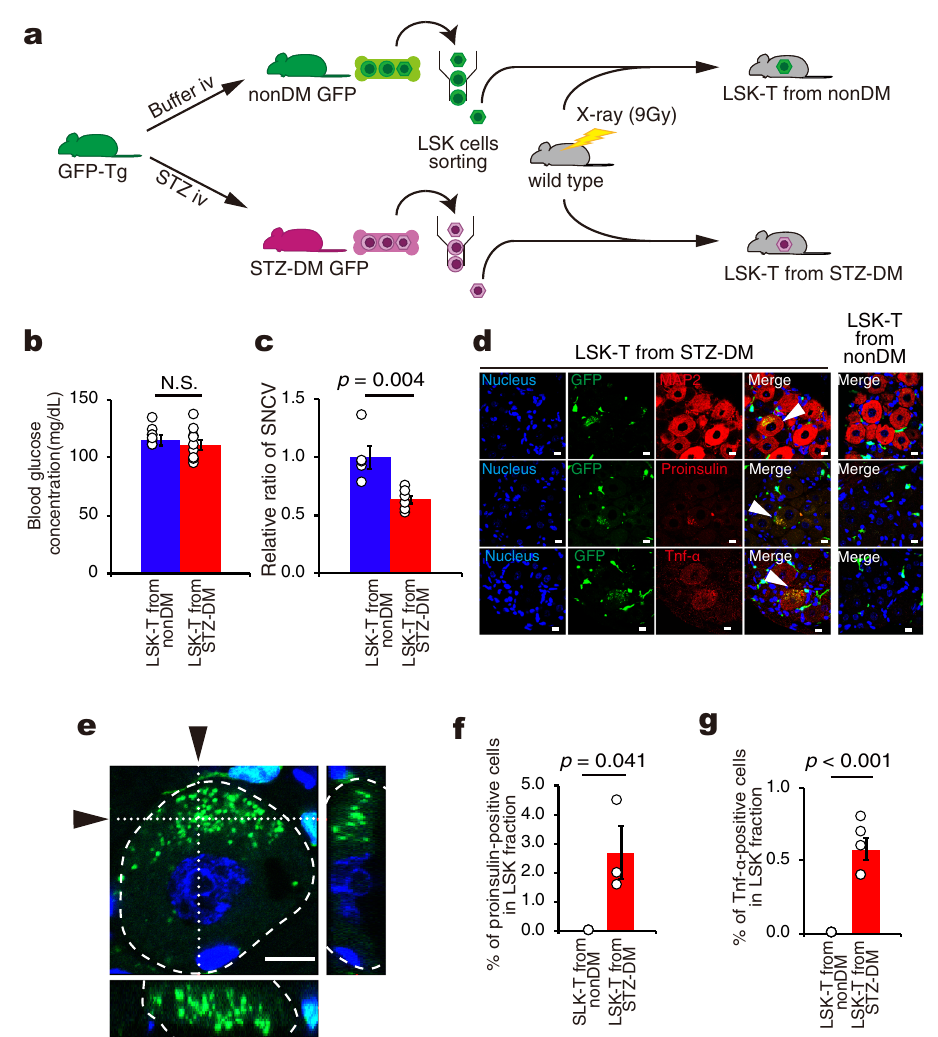
Fig. 2 Cell fusion and development of neuropathy in mice transplanted with LSK cells from diabetic mice. a A schematic experimental design for the transplantation of nonDM/STZ-DM LSK cells into normoglycemic mice. Diabetes (DM) was induced by STZ in GFP-Tg mice (STZ-DM GFP) while intravenous citrate buffer injection was used for the nonDM controls (nonDM GFP). Three months later, LSK cells obtained either from nonDM or STZ-DM mice were transplanted into 9 Gy lethally-irradiated normoglycemic wild type mice (LSK-T from nonDM or LSK-T from STZ-DM, respectively). b Blood glucose concentration of LSK-T from nonDM ( n = 8) and LSK-T from STZ-DM ( n = 10). N.S means not signi fi cant. c Relative ratio of SNCV in the sciatic nerve following LSK-T from STZ-DM mice ( n = 6) compared to LSK-T from nonDM donors ( n = 5). d Immuno fl uorescent staining of the dorsal root ganglion (DRG) showing nuclei (blue), GFP (green), MAP2 (red), proinsulin (red), and TNF- α (red), and merged images in LSK-T from nonDM and LSK-T from STZ-DM mice. Arrowheads showed fusion cells. Scale bars = 10 μ m. e Z-stack imaging of DRG from LSK-T from STZ-DM. Narrow images indicate the cross-section of x -axis or y -axis (whited dotted line) in DRG neuron surrounded by white dashed line. Arrows indicate the position of cross-section. Green showed GFP. Blue showed nucleus. Scale bar = 10 μ m. f FACS analysis of proinsulin-positive cells in the LSK fraction from mononuclear cells in LSK-T from nonDM and LSK-T from STZ-DM. The percentage of proinsulin-positive cells among LSK cells ( n = 3 per group). g FACS analysis of TNF- α -positive cells among LSK cells from mononuclear cell in LSK-T from nonDM and LSK-T from STZ-DM. The percentage of TNF- α -positive cells among LSK cells ( n = 5 per group). Data are indicated as means ± SE.